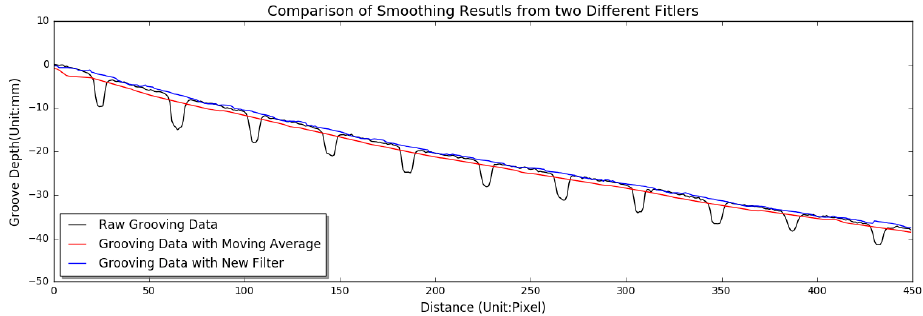
Figure 4. Comparison of smoothing results with moving average filter and the new filter.